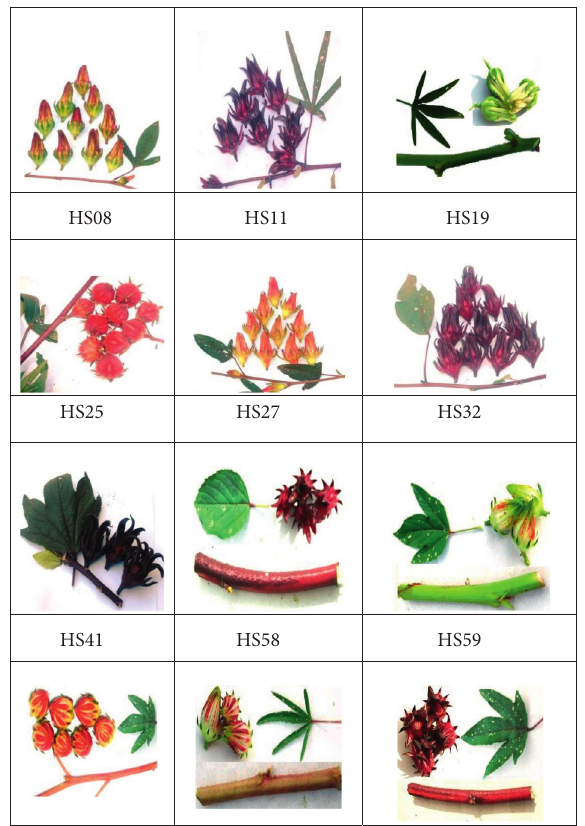
Figure 1: Pictorial presentation of the selected twelve distinctly different